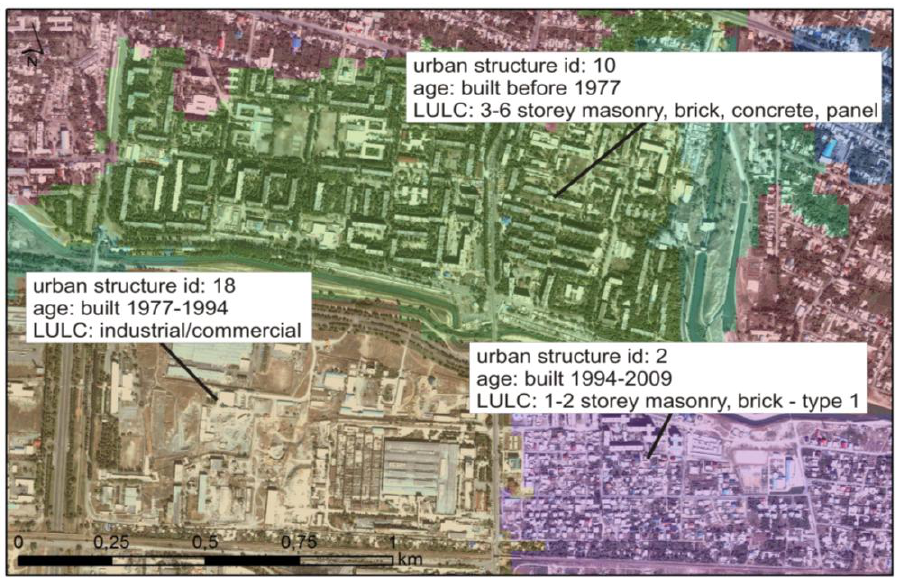
2. Subset of urban structure types stratification from an analysis of medium-resolution satellite images (superimposed on the Quickbird